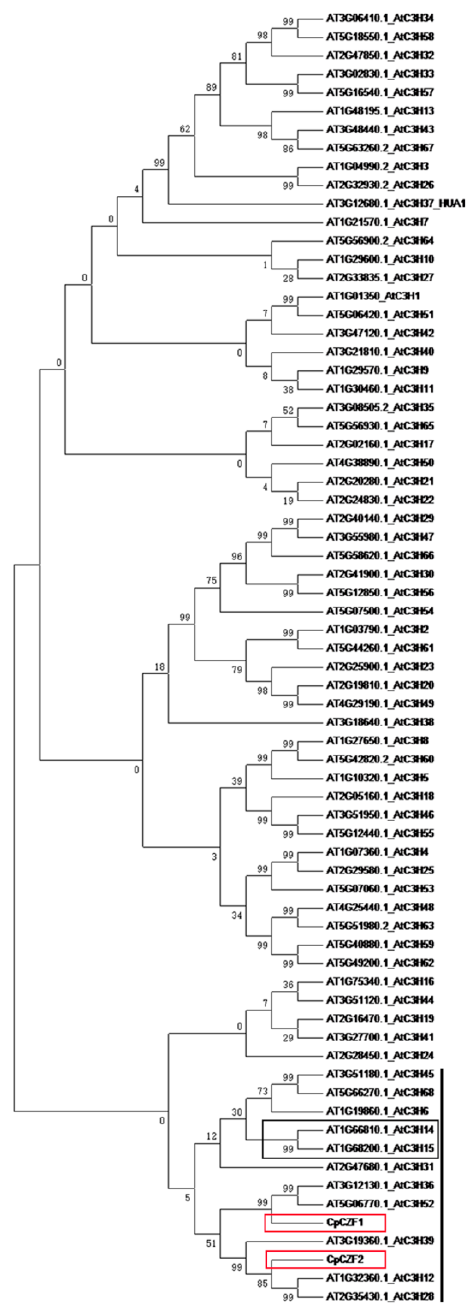
Figure 2. Phylogenetic analysis of CpCZF1, CpCZF2, and C3H-type proteins in Arabidopsis . CpCZF1, CpCZF2, and the accession numbers of zinc finger protein genes are shown in the phylogenetic tree. The blank line indicates the branch which CpCZF1 and CpCZF2 are clustered to. The red boxes indicate the position of CpCZF1 and CpCZF1; the blank box indicates the position of AtC3H14 and